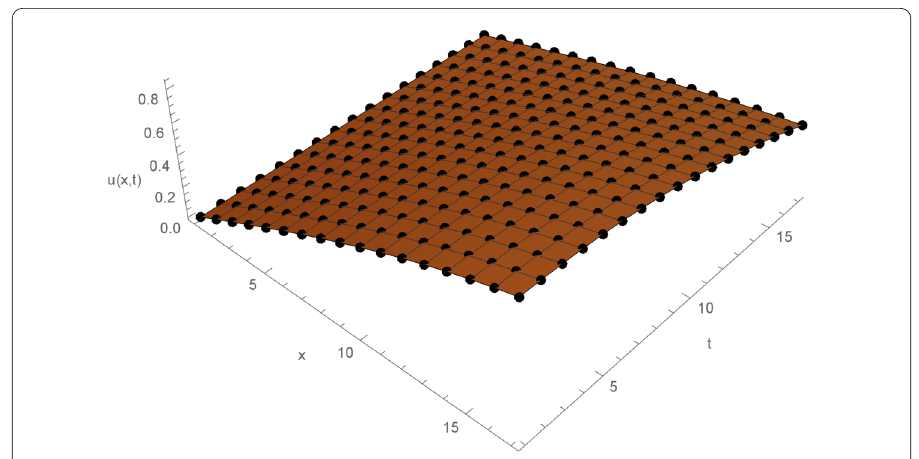
Figure 6 3D plot for the exact and approximated solution of Problem 3